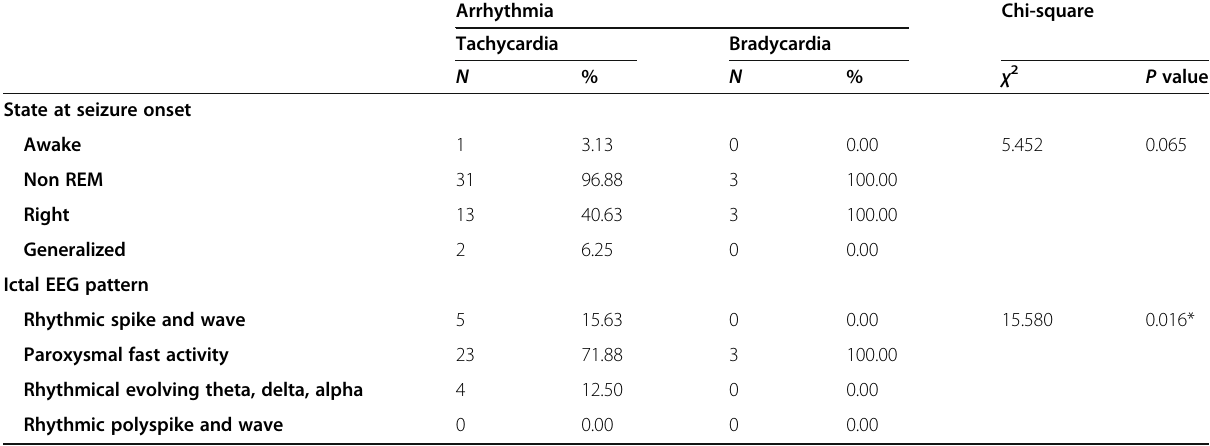
Table 6 Correlations between heart rate changes and ictal EEG pattern and state at seizure onset Arrhythmia Chi-square Tachycardia